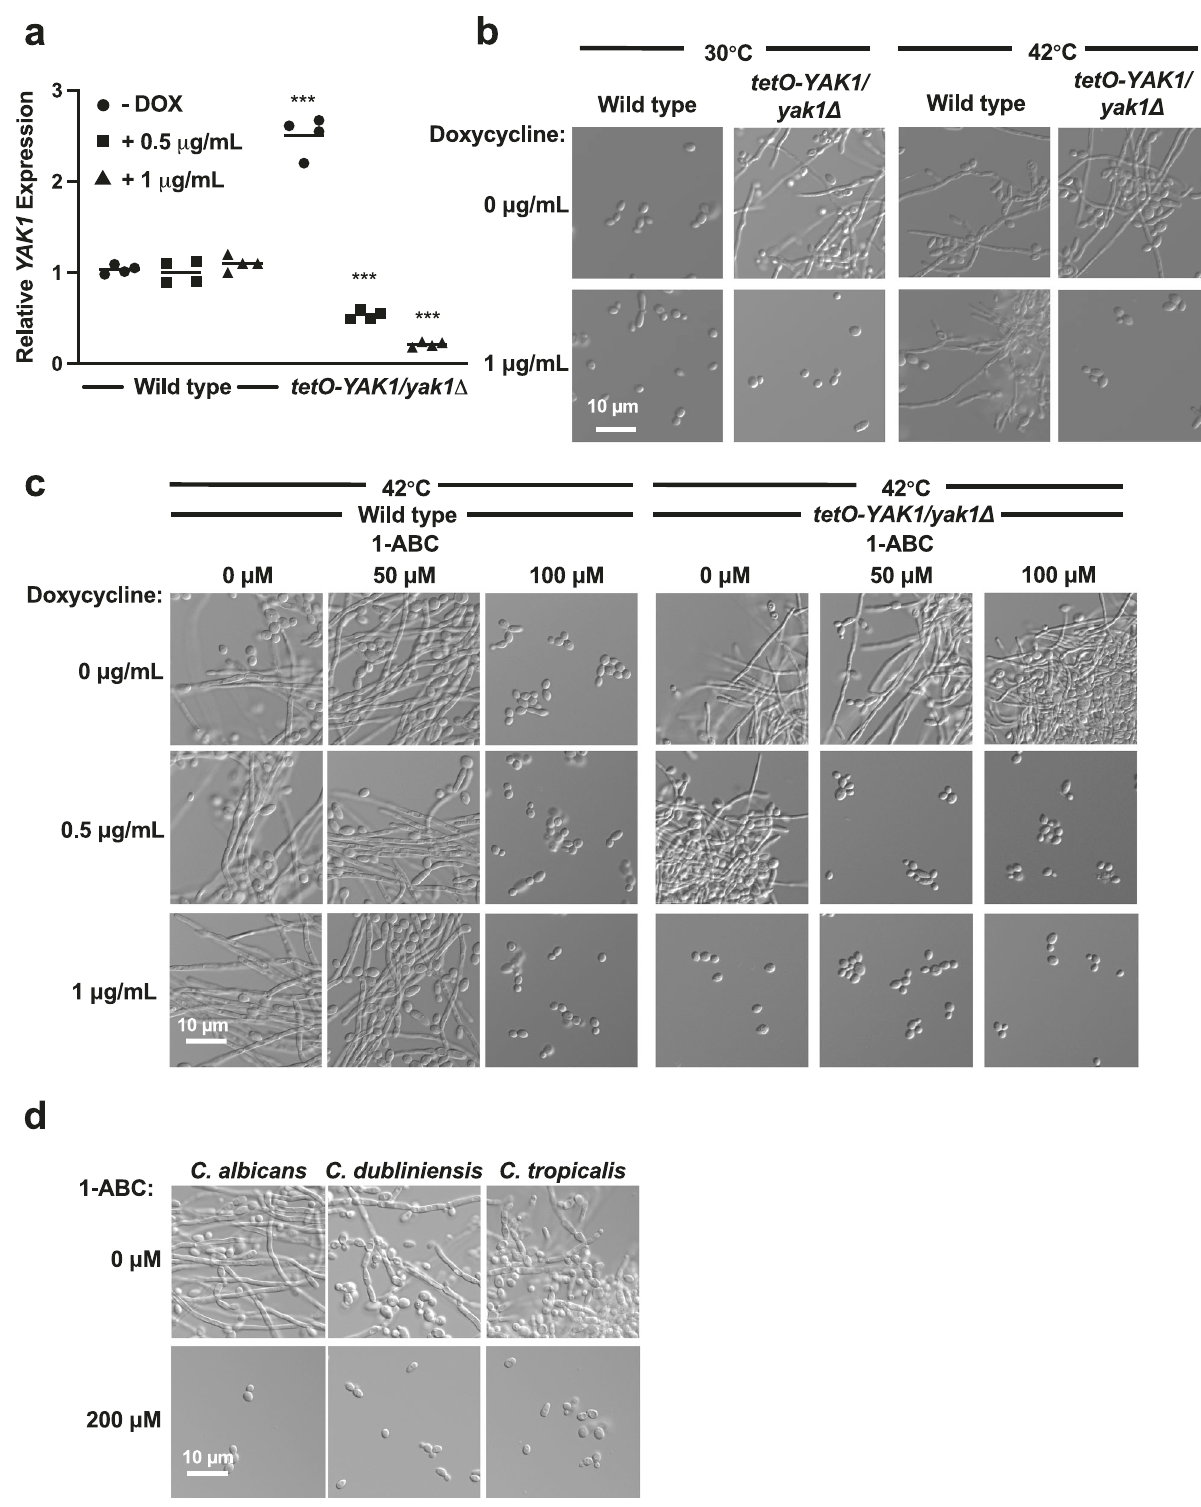
model for the structure of C. albicans Yak1 kinase domain based on previously published crystallographic data for DYRK-family kinases. Using this model, we observed a good fi t upon docking 1-ECBC into the Yak1 ATP-binding pocket (predicted binding energy − 8.5 kcal/mol) with a binding mode that is highly conserved with experimental data for co-crystal structures of the β -carboline harmine in complex with mammalian DYRK1A